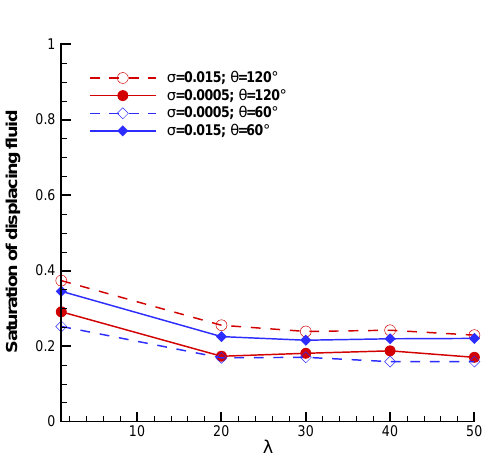
Figure 6. Displacing fluid saturation as a function of viscosity ratio for the four typical cases listed in Table 1.